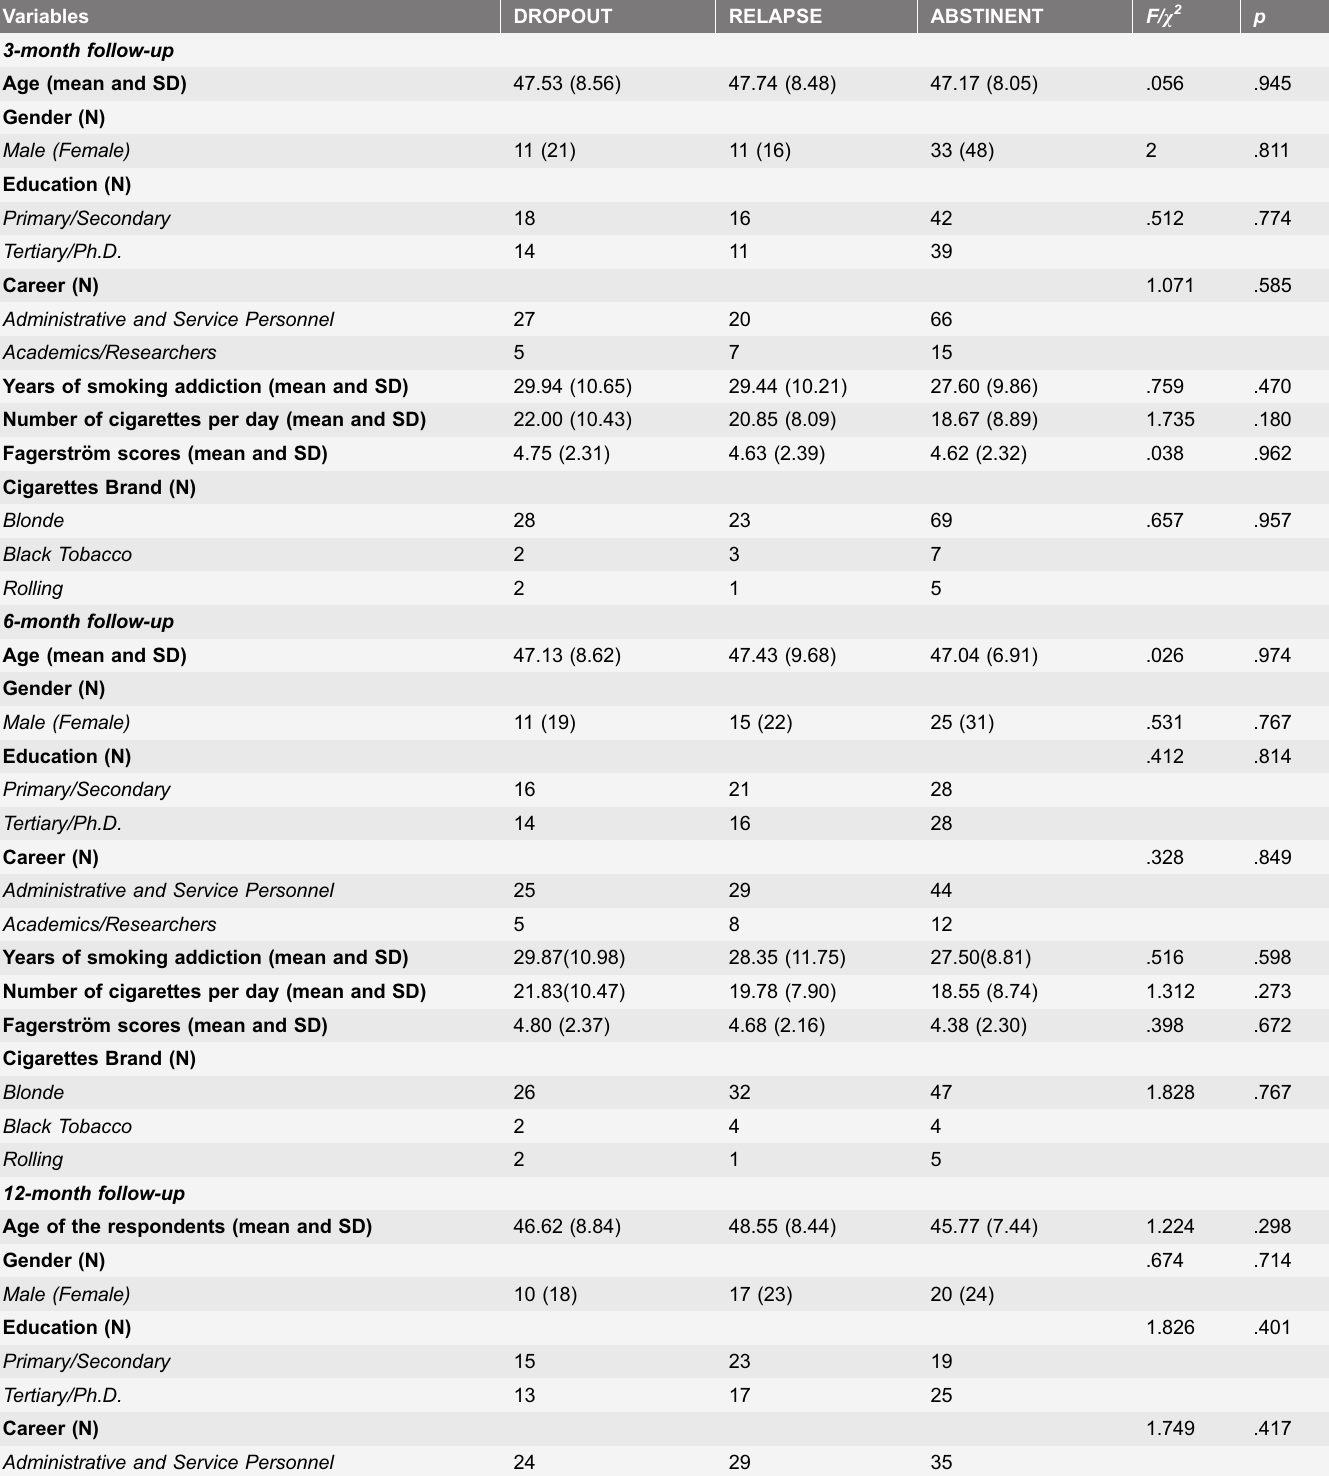
Table 2. Baseline demographic and variables related to cigarette smoking of the participants classified in each of these categories (dropout versus relapse versus